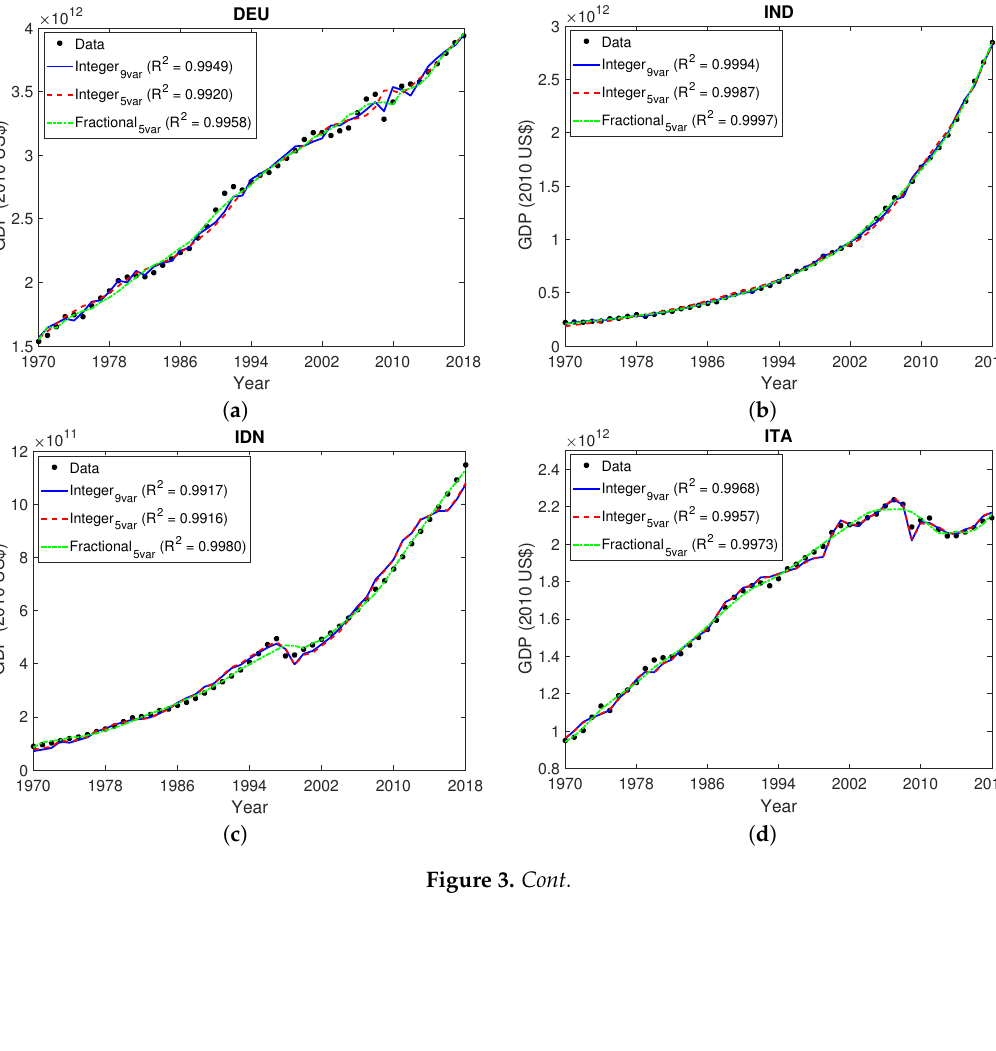
Figure 2. Results obtained with integer and fractional models for the following members of the G20: ( a ) Argentina ( b ) Australia ( c ) Brazil ( d ) Canada ( e ) European Union ( f ) France. GDP estimations were obtained with integer models (1) and (2) and with fractional model (3). R 2 values are given to show the quality of the results of each model. As GDPs have different orders of magnitude, different scales were used in the y -axis for different countries.